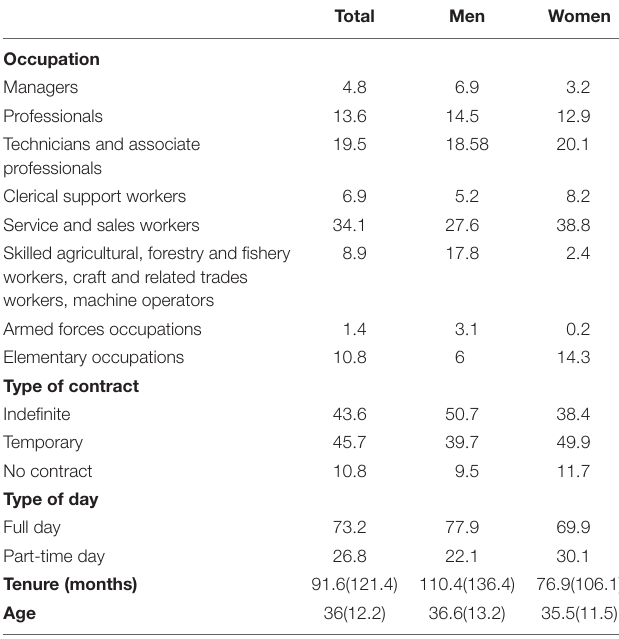
TABLE 1 | Percentage distributions, means, and Standard Deviations of labour profiles of the